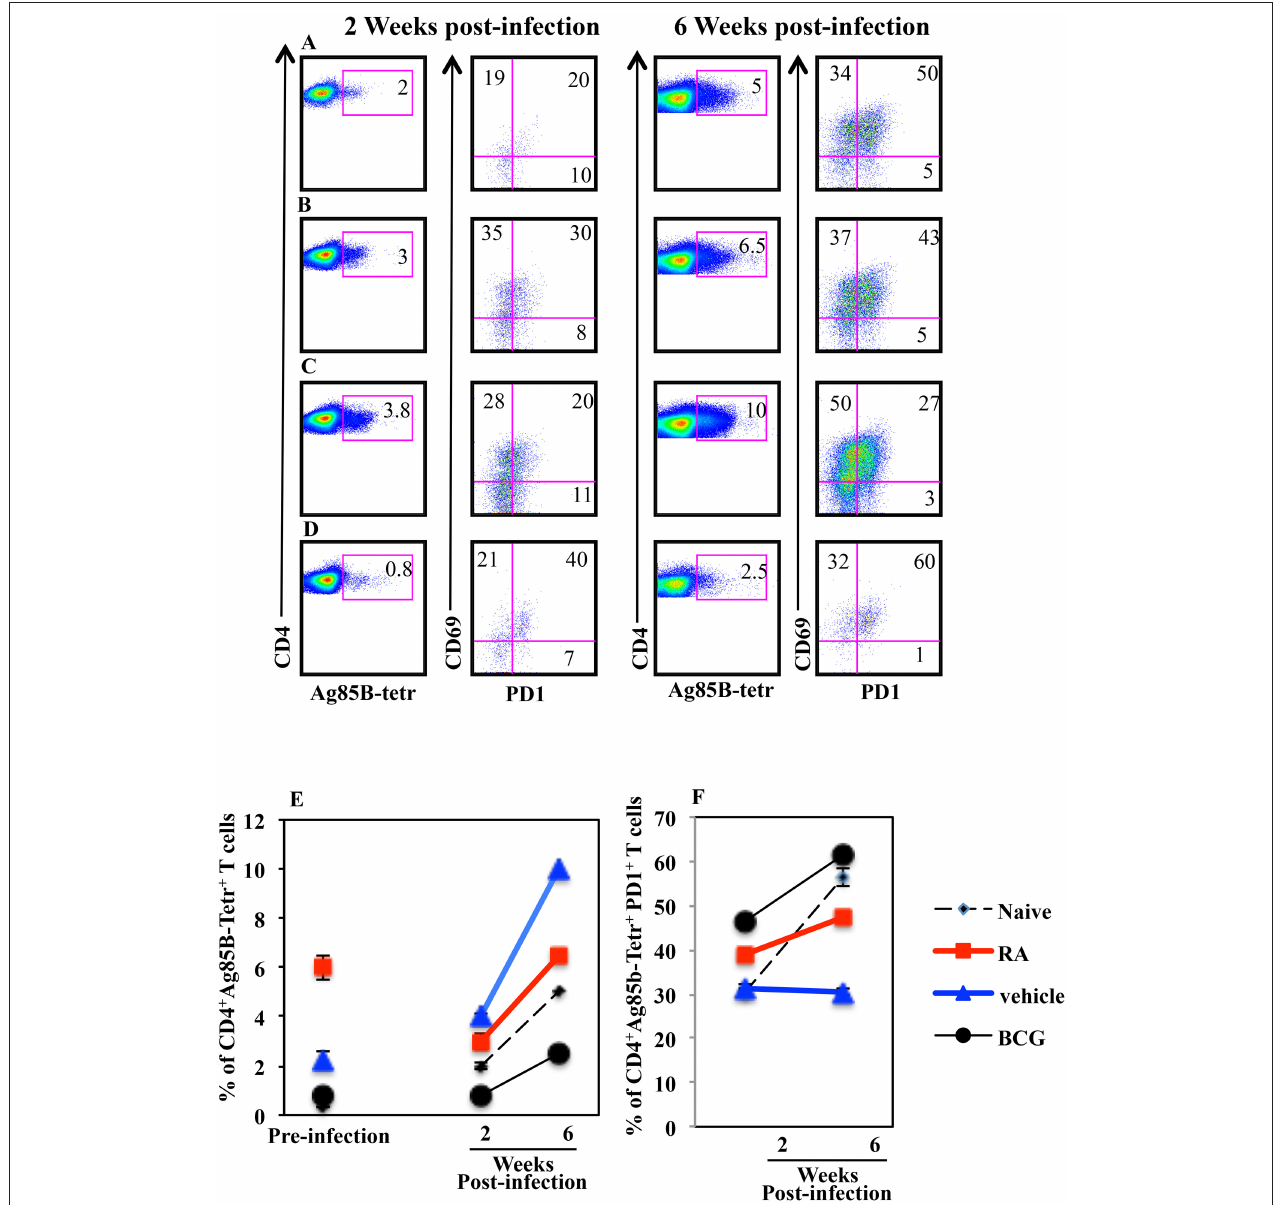
FIGURE 6 | Higher percentage of Mtb specific CD4 + PD1 + T lymphocytes in the lungs of infected mice immunized with CAF01 + H56 in presence of RA. Untreated naïve CB6F1 mice (A) or mice treated with RA (B) or its vehicle (C) were immunized with CAF01 (125 µ g/dose) and H56 (0.5 µ g/dose) or immunized with BCG (D) and infected with Mtb 1 month after last immunization. Cells from the lungs were stained with anti-CD4 + , Ag85B + -tetramers and anti-PD1 after 2 (left) and 6 (right) weeks after the infection. The graphs show the percentage of CD4 + Ag85B + cells at pre-infection and 2 and 6 weeks after infection (E) and the percentage of CD4 + Ag85B + PD1 + T cells 2 and 6 weeks after infection (F) . Bars indicate the SEM. One rapresentative experiment is shown of two